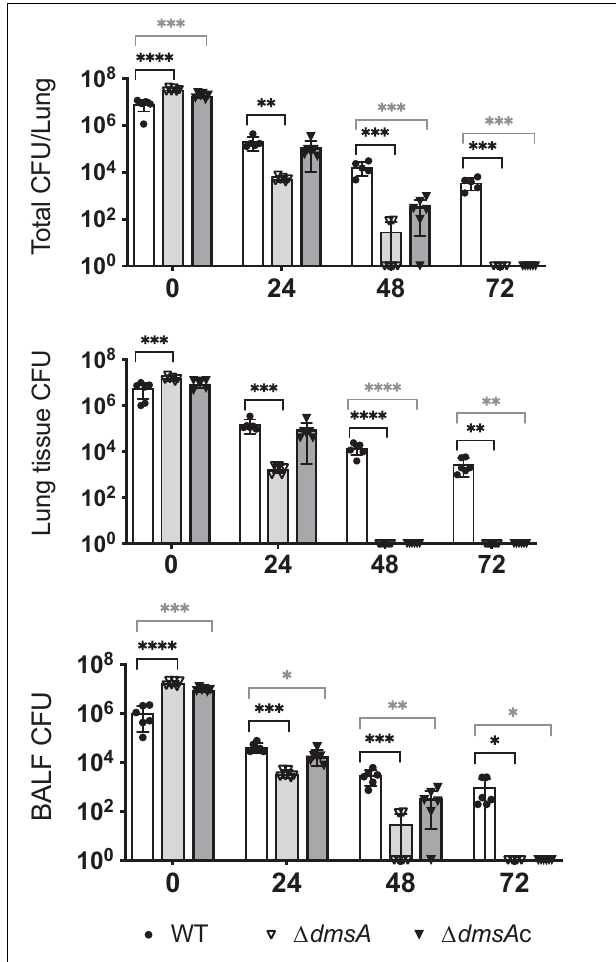
FIGURE 6 | Survival of Hi2019 WT (white), Hi2019 (cid:49) dmsA (light gray), and Hi2019 (cid:49) dmsAc (gray) in a mouse model of lung infection. Top: Total CFU/lung (tissue + bronchoalveolar lavage fluid (BALF)), Middle: CFU/lung tissue, Bottom: CFU/BALF. Hi2019 (cid:49) dmsA is essentially cleared after 48 h of infection, an effect that was mostly reversed in Hi2019 (cid:49) dmsAc . Each group consisted of six mice. Statistical testing used one-way ANOVA ( post hoc test: Dunnett), ∗ p < 0.05, ∗∗ p < 0.01, ∗∗∗ p < 0.001, ∗∗∗∗ p <